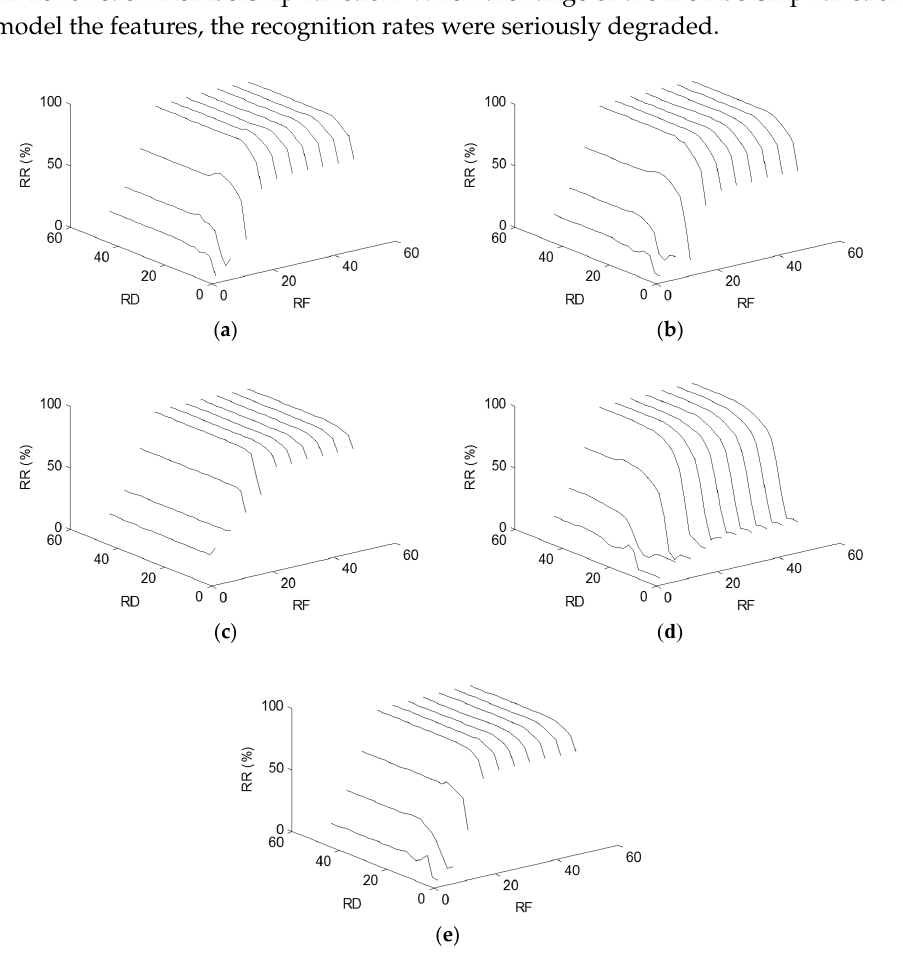
Figure 6. Recognition rates for ( a ) TriaMF; ( b ) TrapMF; ( c ) GbellMF; ( d ) GaussMF; and ( e ) Gauss2MF. RD, RF, and RR are the output range of defuzzification, the input range of fuzzification, and recognition rate, respectively.